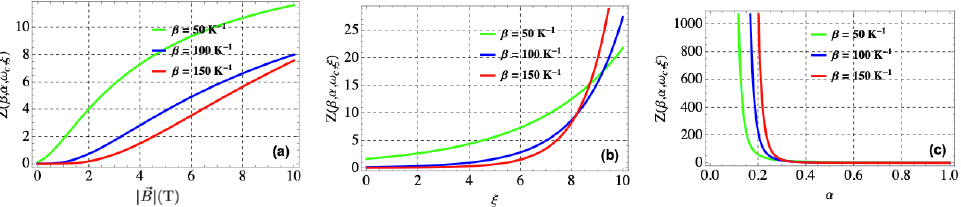
Figure 1. ( a ) Plot of partition function Z ( β ) as a function of magnetic field | (cid:126) B |(T) with different values of β and fixed values of α = 0.4 and ξ = 6. ( b ) Plot of Z ( β ) as a function of ξ for different values of β and fixed values of | (cid:126) B | = 4 T and α = 0.4. ( c ) Z ( β ) plot as a function of α for different values of β and fixed values of | (cid:126) B | = 6 T and ξ = 6. For all three plots, β = 50 k − 1 (green curve), 100 k − 1 (blue curve) and 150 k − 1 (red curve) and the maximum vibrational quantum n max is fixed at n max = 100, p = q = 0.15 and δ = 0.005.